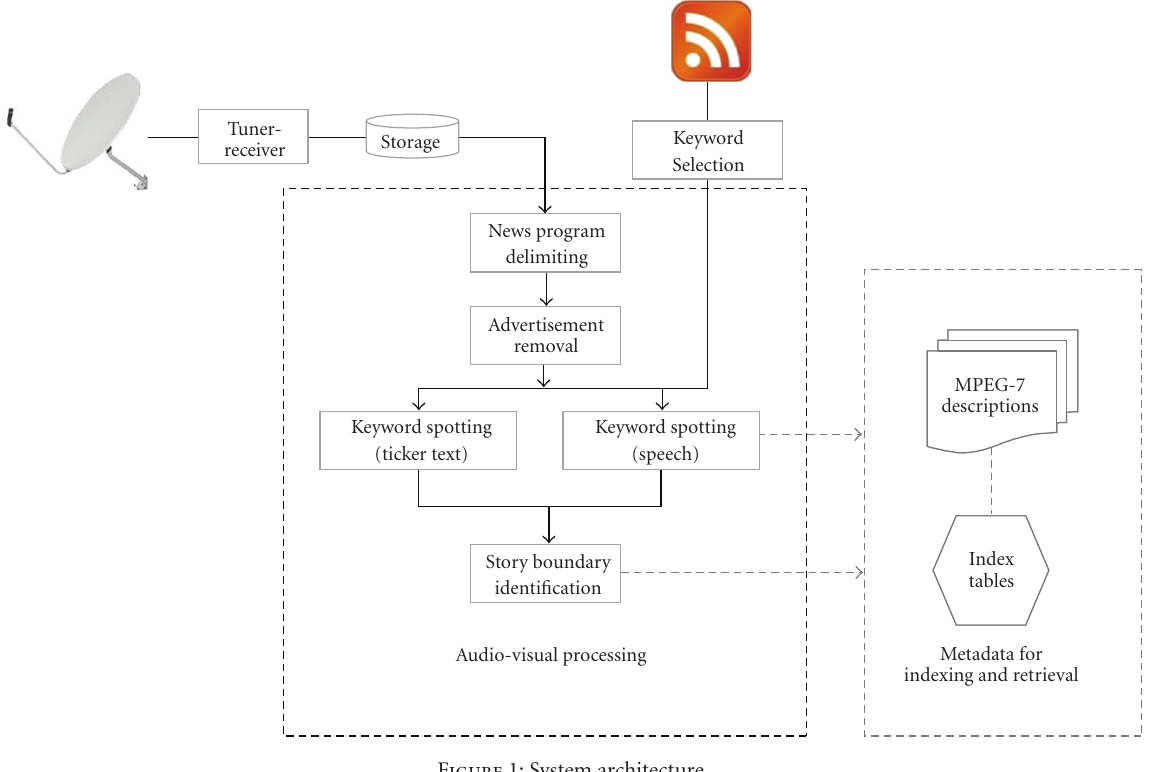
Figure 1: System